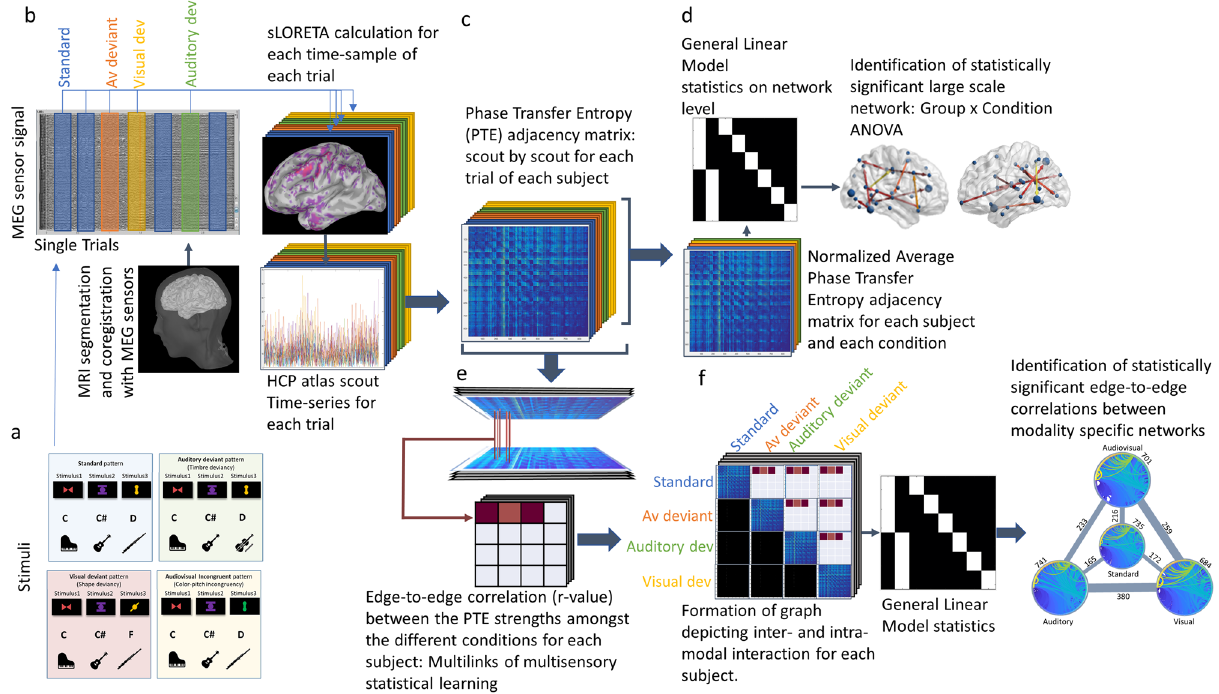
Figure 7. Description of the study’s design: ( A ): A multifeatured multisensory statistical learning stimulation paradigm was applied to 12 musicians and 13 non-musicians. Conditions were: audiovisual standard, audiovisual deviant, auditory deviant, visual deviant. ( B ): MEG data were recorded and analyzed in single trial using an individual head model. Source activity of the 360 regions included in the HCP atlas was calculated via sLORETA for each sample point. ( C ): Phase Transfer Entropy (PTE) amongst the 360 source activities was estimated to generate an adjacency matrix for each trial. ( D ): PTE values of each trial were separately averaged and normalized for each condition, compared via a General Linear Model approach to generate the networks supporting statistical irregularity identification separately for the auditory, visual and audiovisual modalities. Significance was set to p < 0.05, corrected for multiple comparisons via FDR, using 10.000 permutations. ( E ): Inter- and intra modal network formation: Calculation of edge-to-edge correlation between the PTE values of the different conditions for each subject. Non-significant correlations were thresholded. ( F ): Formation of a multilayer graph for each subject, representing both between and within task-defined network state connectivity. General Linear Model approach was used for the statistical comparison of the corresponding graphs, depicting between and within modality-specific network connectivity. Significance was set to p < 0.05, corrected for multiple comparisons via FDR, using 10.000